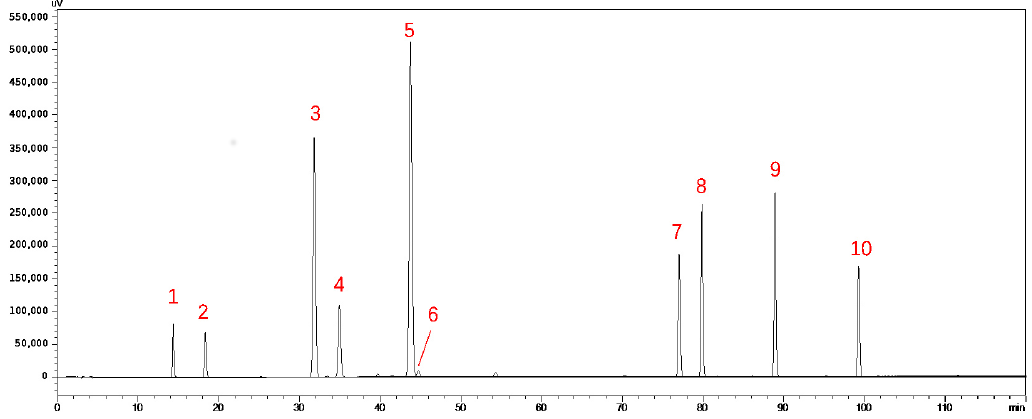
Figure 6. HPLC chromatogram of ten standard materials (1. (+)-catechin; 2. ( − )-epicatechin; 3. rutin; 4. sennoside B; 5. quercitrin; 6. sennoside A; 7. naringenin; 8. kaempferol; 9. rhein; 10. emodin).